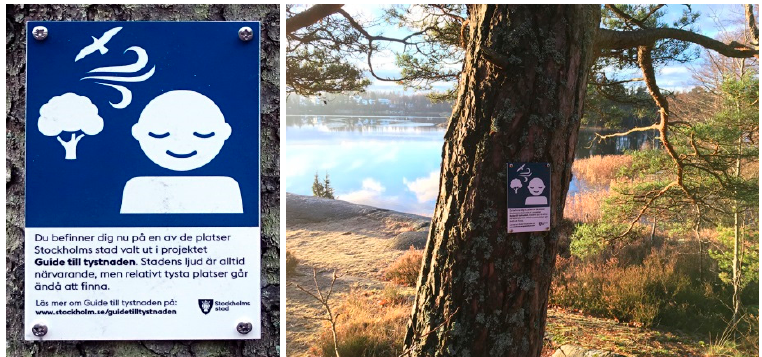
Figure 6. In the “Guide to Silence” concept, quiet areas are marked by signs. This one reads: “You are now in one of the places chosen by the City of Stockholm for the project “Guide to Silence”. The sounds of the city are always present, but relative quietness can be found.” Photo and illustration: Ulf Bohman.